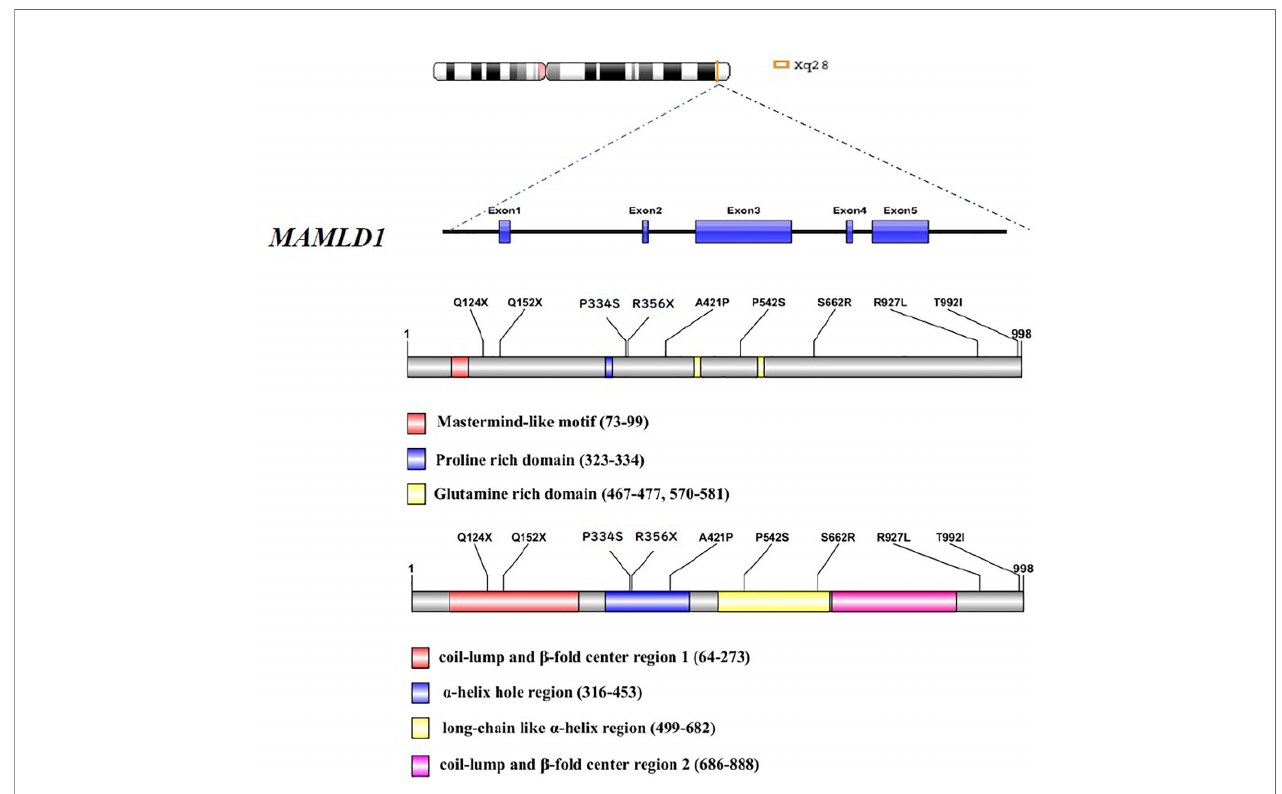
FIGURE 3 | Detailed variation information of functional domains of the nine MAMLD1